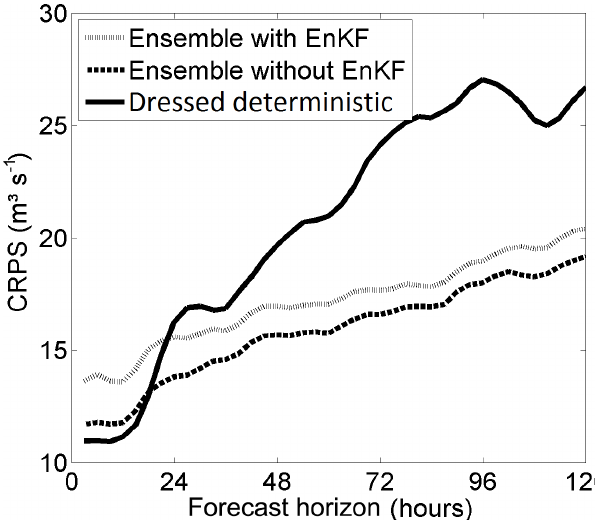
Figure 5. Mean CRPS as a function of lead time for the 2011–2014 period for the forecasts based on meteorological ensembles with (grey line) and without (dashed black line) state variable perturba- tions and for the dressed forecasts (solid black line).